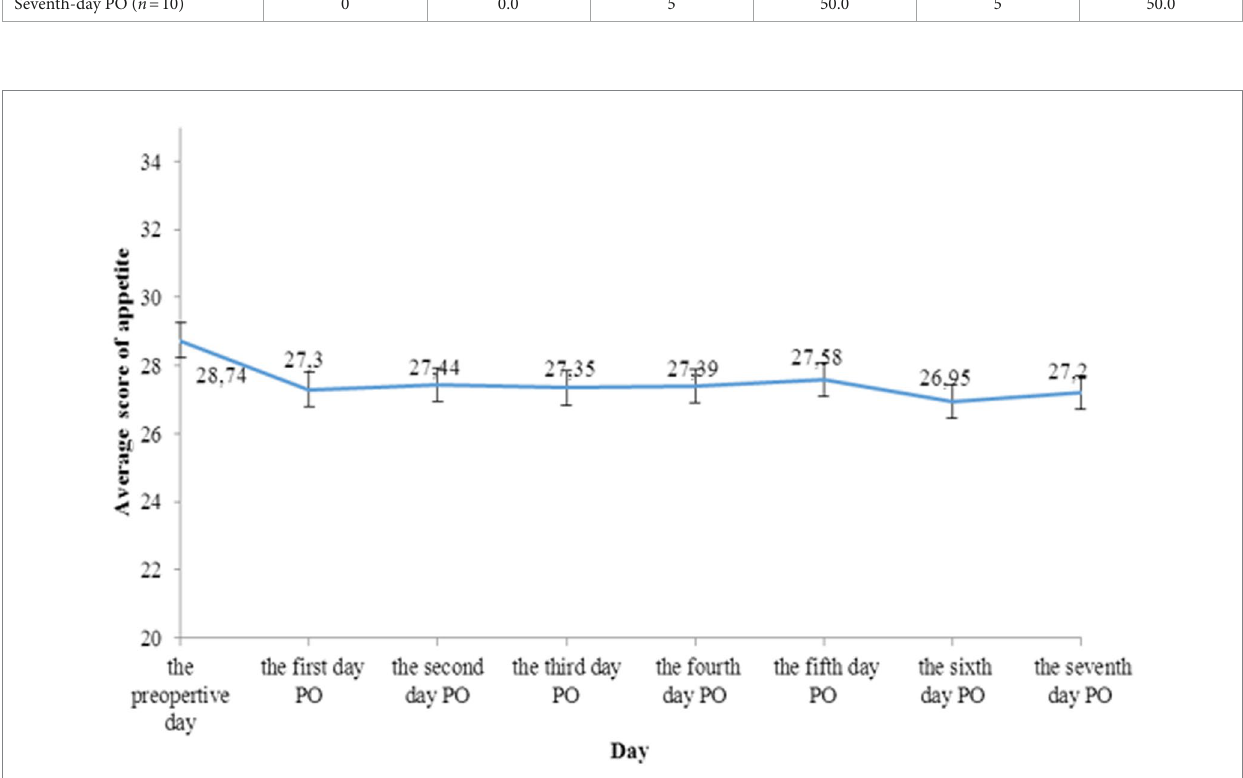
FIGURE 1 Appetite changes in preoperative day and postoperative